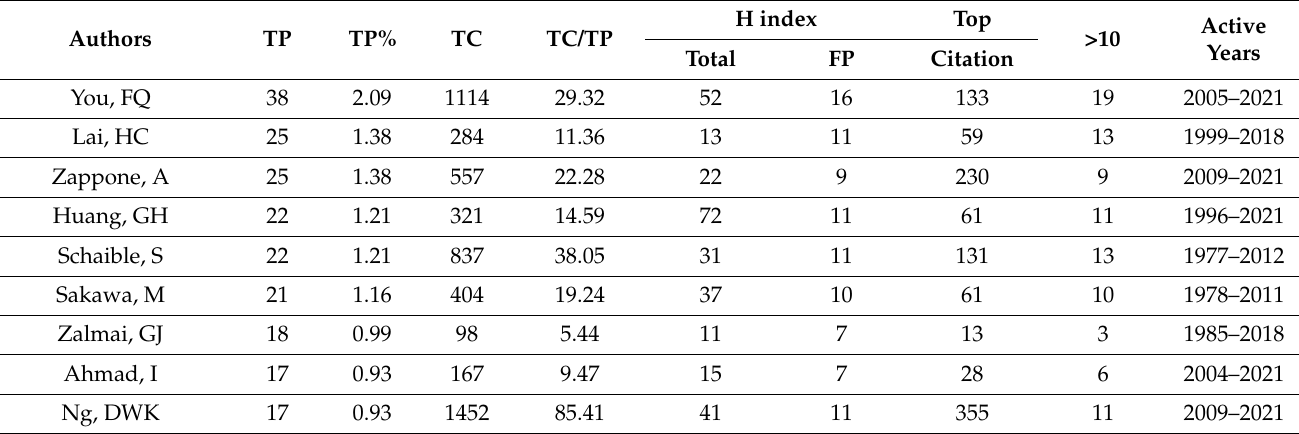
Table 1. Most prolific scholars of Fractional